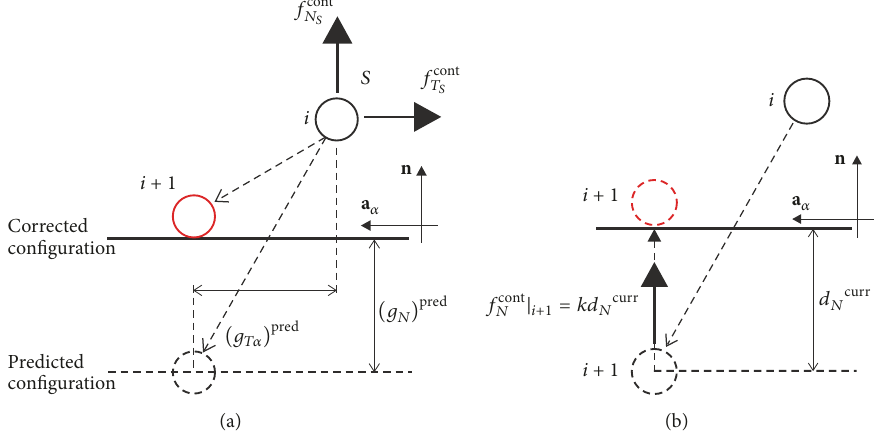
Figure 6: Schemes of contact algorithms [85]: (a) kinematic predictor/corrector; and (b) penalty